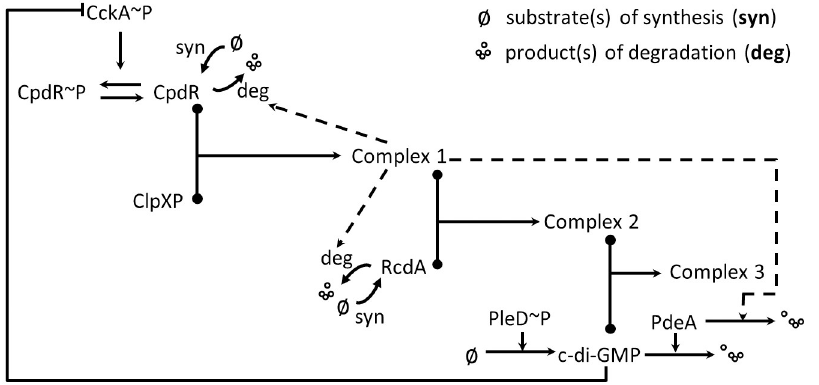
Fig 5. Hierarchical diagram of protease complexes. Solid lines with arrow denote metabolisms; solid lines with filled circles denote binding processes; dashed lines with arrow denote activation effects. Complex 1 decays the first class of substrates; Complex 2 degrades the second class of substrates; Complex 3 degrades the third class of substrates.